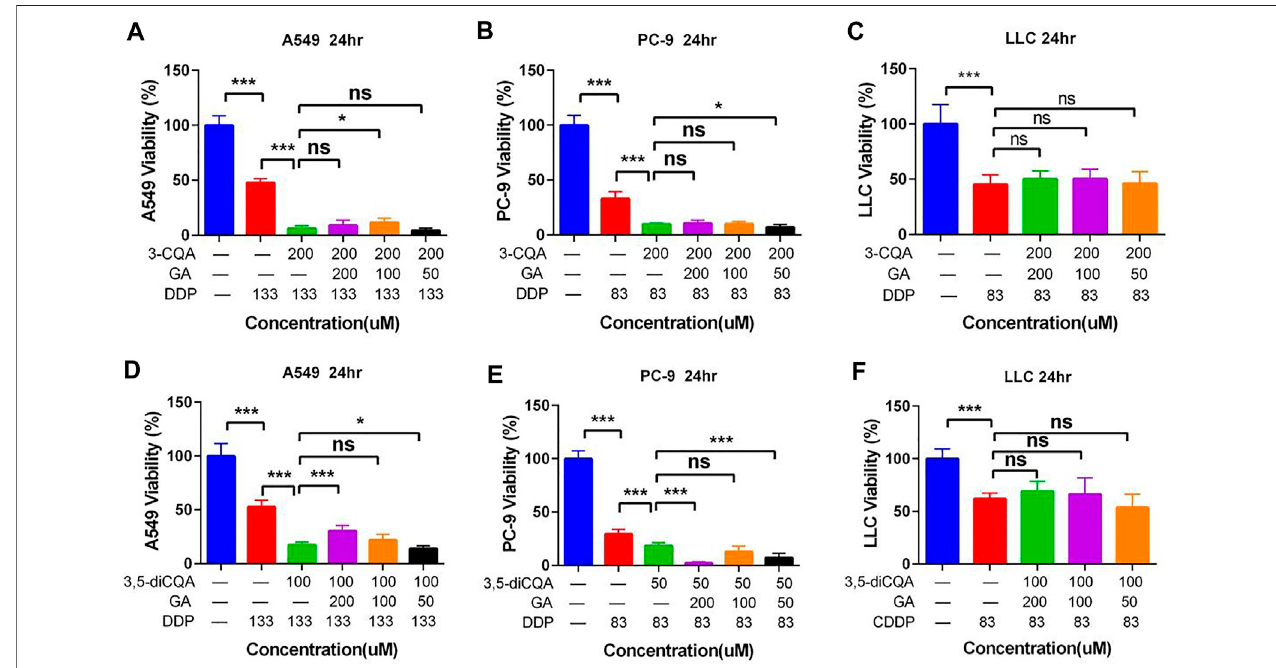
FIGURE 9 | The effect of two natural compounds combined with cisplatin on the viability of lung cancer cells. (A – C) Chlorogenic acid (3-CQA) combined with glycyrrhizic acid (GA) on the antitumor activity of DDP in A549, PC9, and LLC cells. (D – F) 3,5-Dicaffeoylquinic acid (3,5-diCQA) combined with glycyrrhizic acid (GA) on theantitumor activity ofDDPinA549,PC9,and LLCcells.Errorbarsarerepresentedasmean±SEM.The p valuesweredetermined byStudent ’ sttest(* p < 0.05, ** p < 0.01, *** p < 0.001).